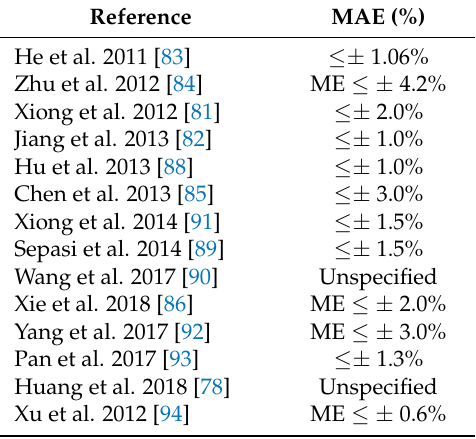
Table 7. MAE/ME of the EKF, variants of the EKF and hybrid EKF-based SOC estimation method.